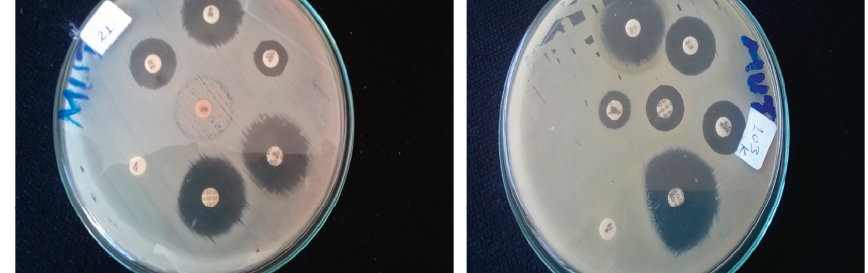
Table 4: Antimicrobial susceptibility pattern of MSSA and MRSA from wound-infected patients at Arba Minch Hospital, Arba Minch, South Ethiopia, April to June 2017. Isolate